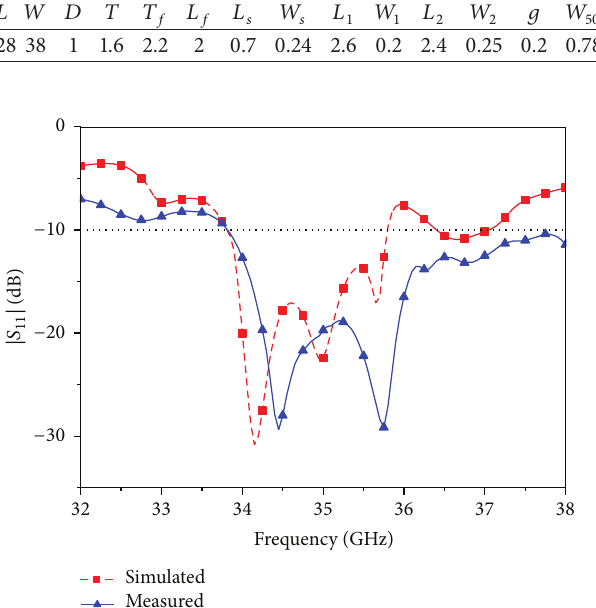
Figure 9: Simulated and measured 𝑆 -parameters.